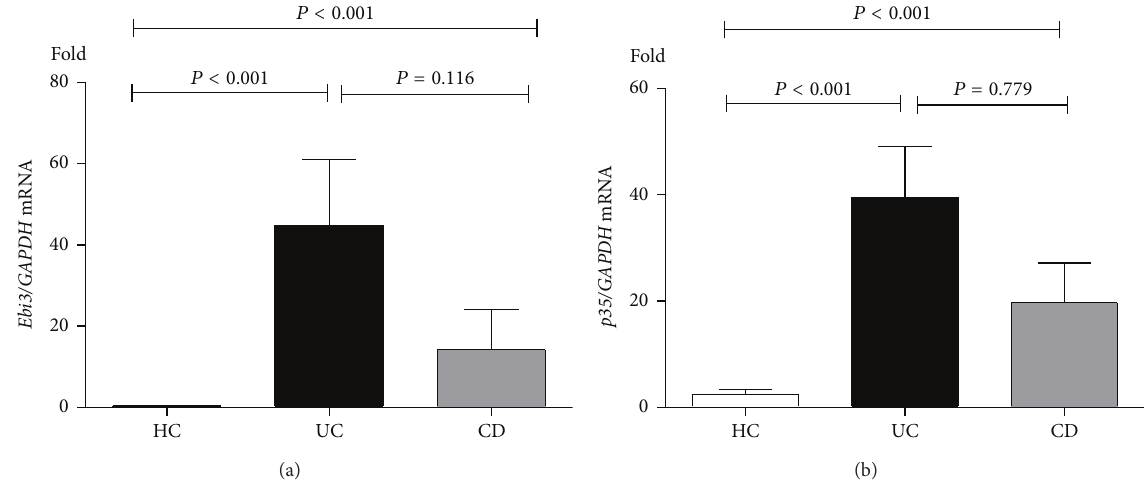
Figure 3: Detection of Ebi3 and p35 mRNA by qRT-PCR. Ebi3 (a) and p35 (b) were significantly overexpressed in endoscopic specimens in both UC patients and CD patients as compared to controls ( 𝑃 < 0.001 ). Ebi3 and p35 mRNA expression in UC and CD biopsies did not reach statistical significance.